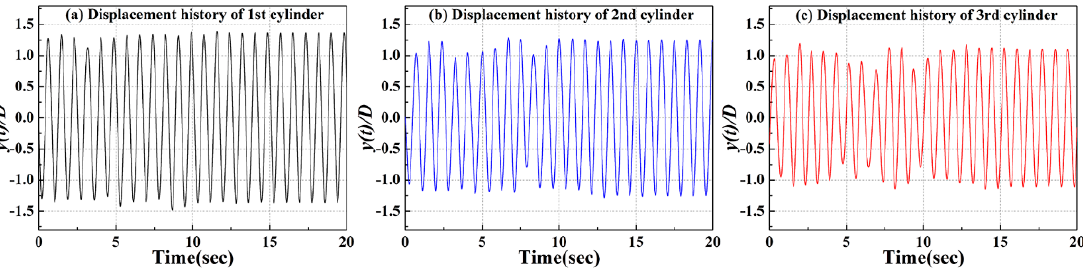
Figure 11. Time history curves of displacement for three cylinders when Re = 60,000.